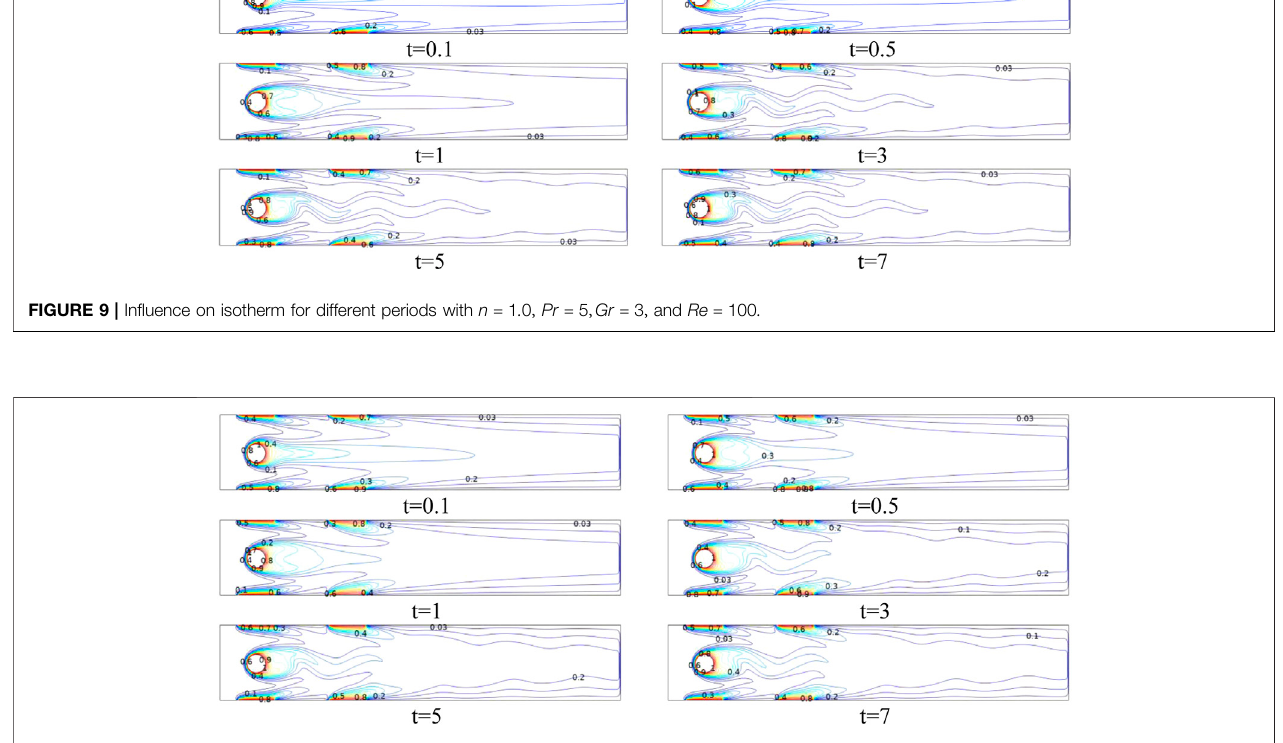
FIGURE 10 | In fl uence on isotherm for different periods with n (cid:2) 1 . 0 , Pr (cid:2) 5 , Gr (cid:2) 10 , and Re (cid:2) 100